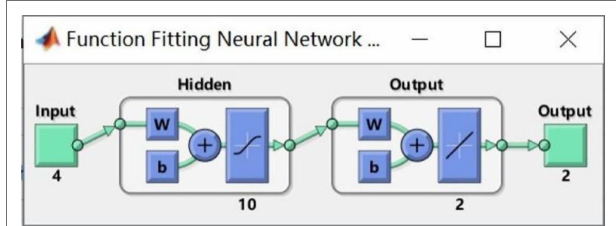
FIGURE 15 | Neural network diagram.